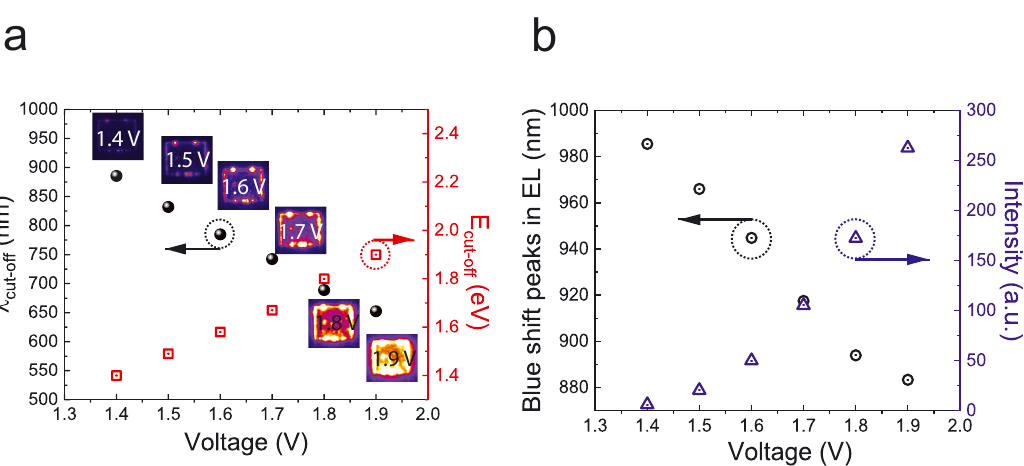
Figure 3: (a) Identification of surface plasmons conversion to photon as observed in electroluminescence experiment of the MIS tunnel junction with the highest doping concentration of 1.0 × 10 20 cm − 3 . The insets show the EMCCD images in real plane corresponding to different voltage bias ( V b ) [16]. λ cut-off is the shortest wavelength emitted. (b) The peaks of spectrum blueshift from 985.5 to 883.4 nm, while the intensities of the peaks increase from 6.14 to 262.40 (a.u) with the voltage bias increasing from 1.4 to 1.9 V.